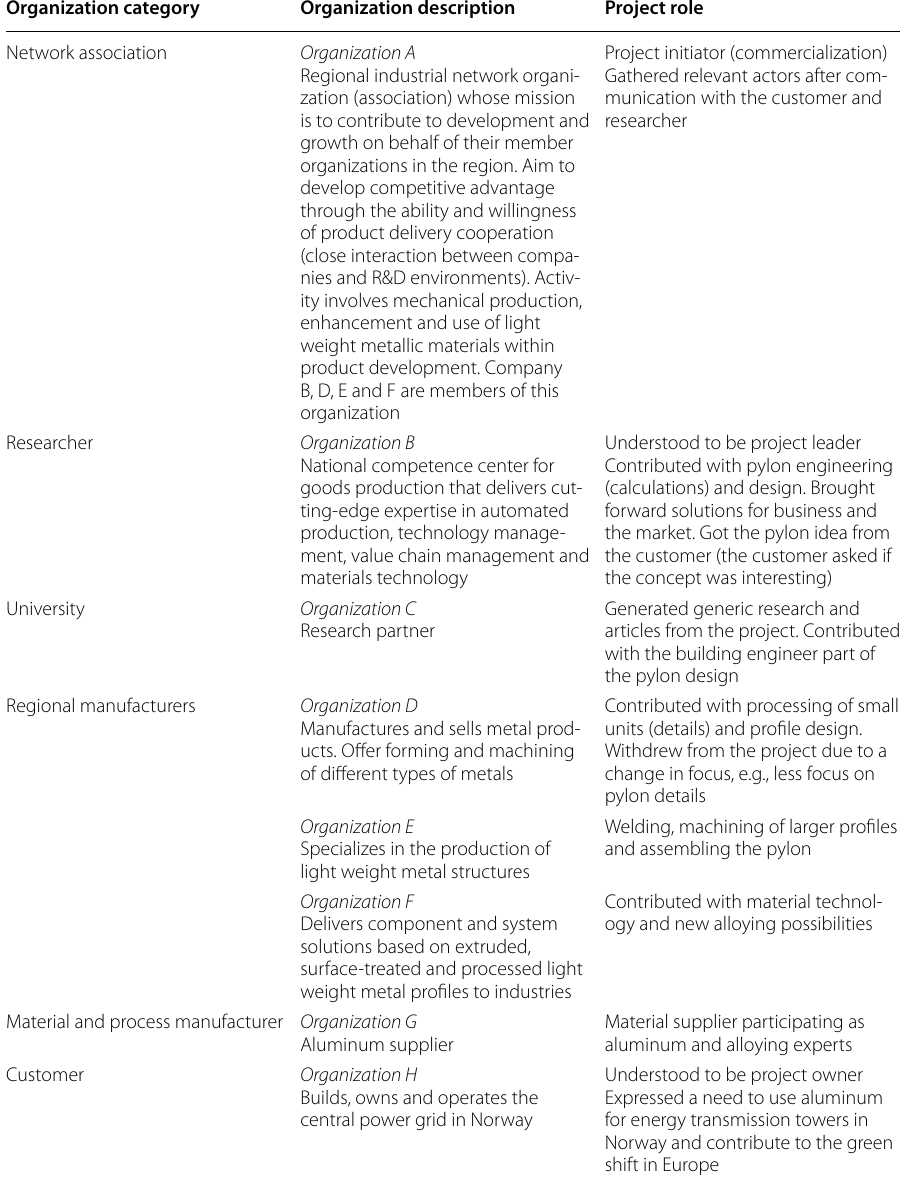
Table 2 Project actors Organization